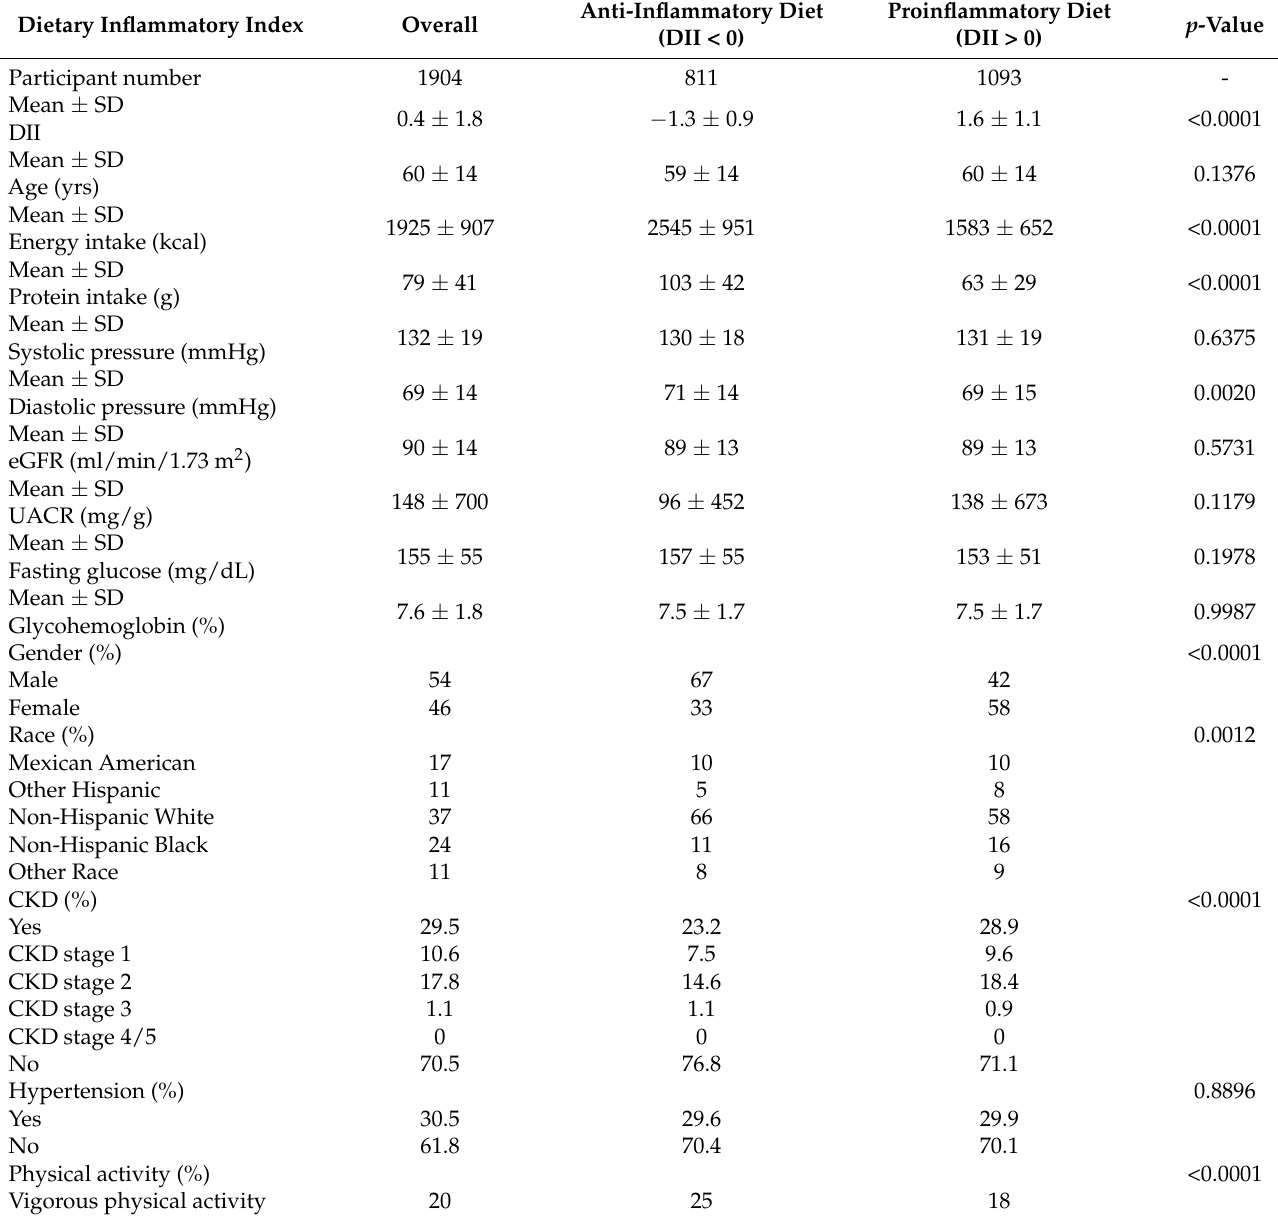
Table 3. Baseline characteristics of participants with diabetes from NHANES 2009–2010, 2011–2012, and